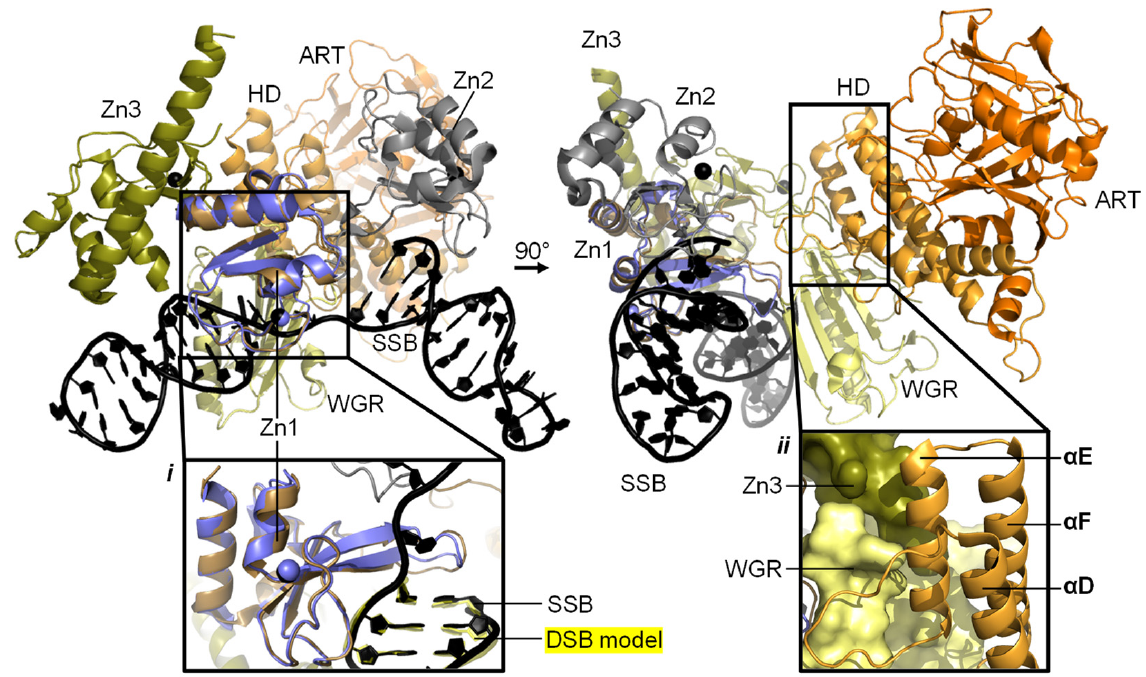
Figure 4. A model of full-length PARP1 on a SSB model. Panels show the resulting composite structure from the superpo- sition of the NMR-structure of Zn1-Zn2 on a SSB model (PDB 2N8A [89]) and the crystal structure of Zn1, Zn3, WGR, HD, and ART on a DSB model (PDB 4DQY [34]) in two views. Domains are annotated, colours correspond to Figure 1 and Zn1 from 4DQY is shown in blue. The composite model was generated through superposing Zn1 and two unpaired and three paired DNA bases of the SSB onto 4DQY, as previously described [1]. Linkers between Zn1-Zn2 and following Zn2 were removed for clarity. Inset i : zoom of the superposition of Zn1 (brown from PDB 2N8A and blue from PDB 4DQY) and the superposed DNA bases of the SSB (black, PDB 2N8A) onto the DSB model (yellow, PDB 4DQY). WGR hidden for clarity. Inset ii : view of the “landing pad” formed through interface formation between Zn3 (olive) and WGR (pale yellow).